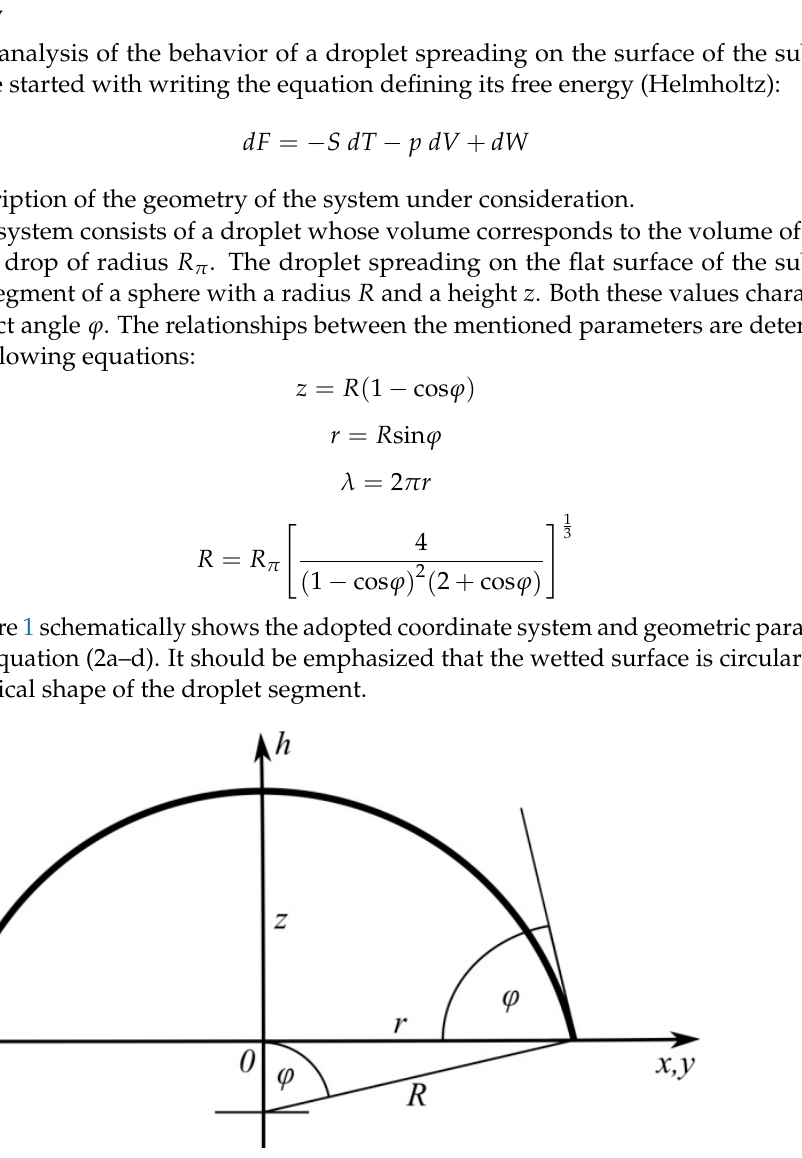
Figure 1. The geometric meaning of the parameters indicated in the figure and applied in the